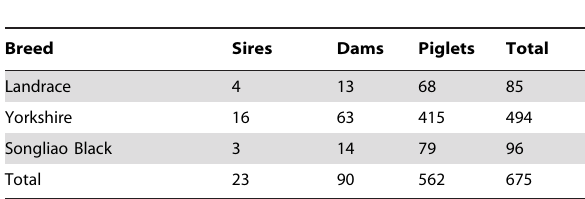
Table 1. Constitution of the study